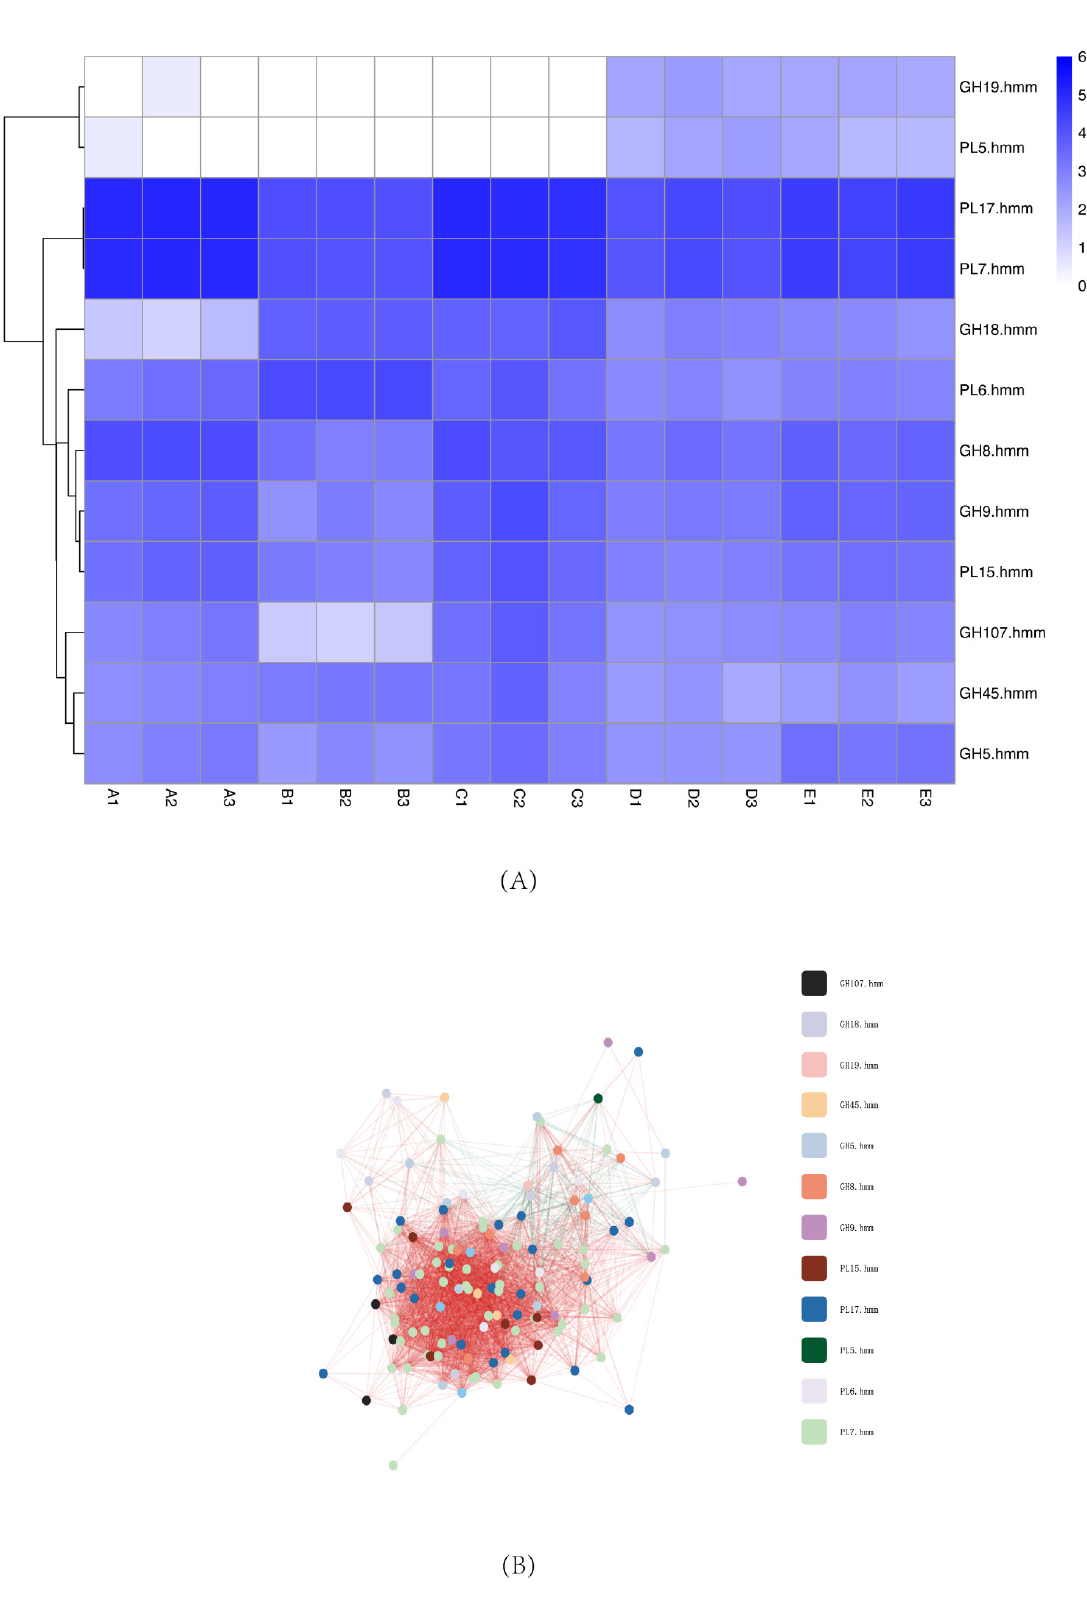
Figure 4. Relative abundance analysis of polysaccharide degradation enzyme (PDE) family. ( A ) Heatmap showing the relative abundances of the PDE family on a log10 scale. ( B ) Co-occurrence network of the PDE (r ≥ 0.5). Positive and negative associations are depicted by light red and light green lines,